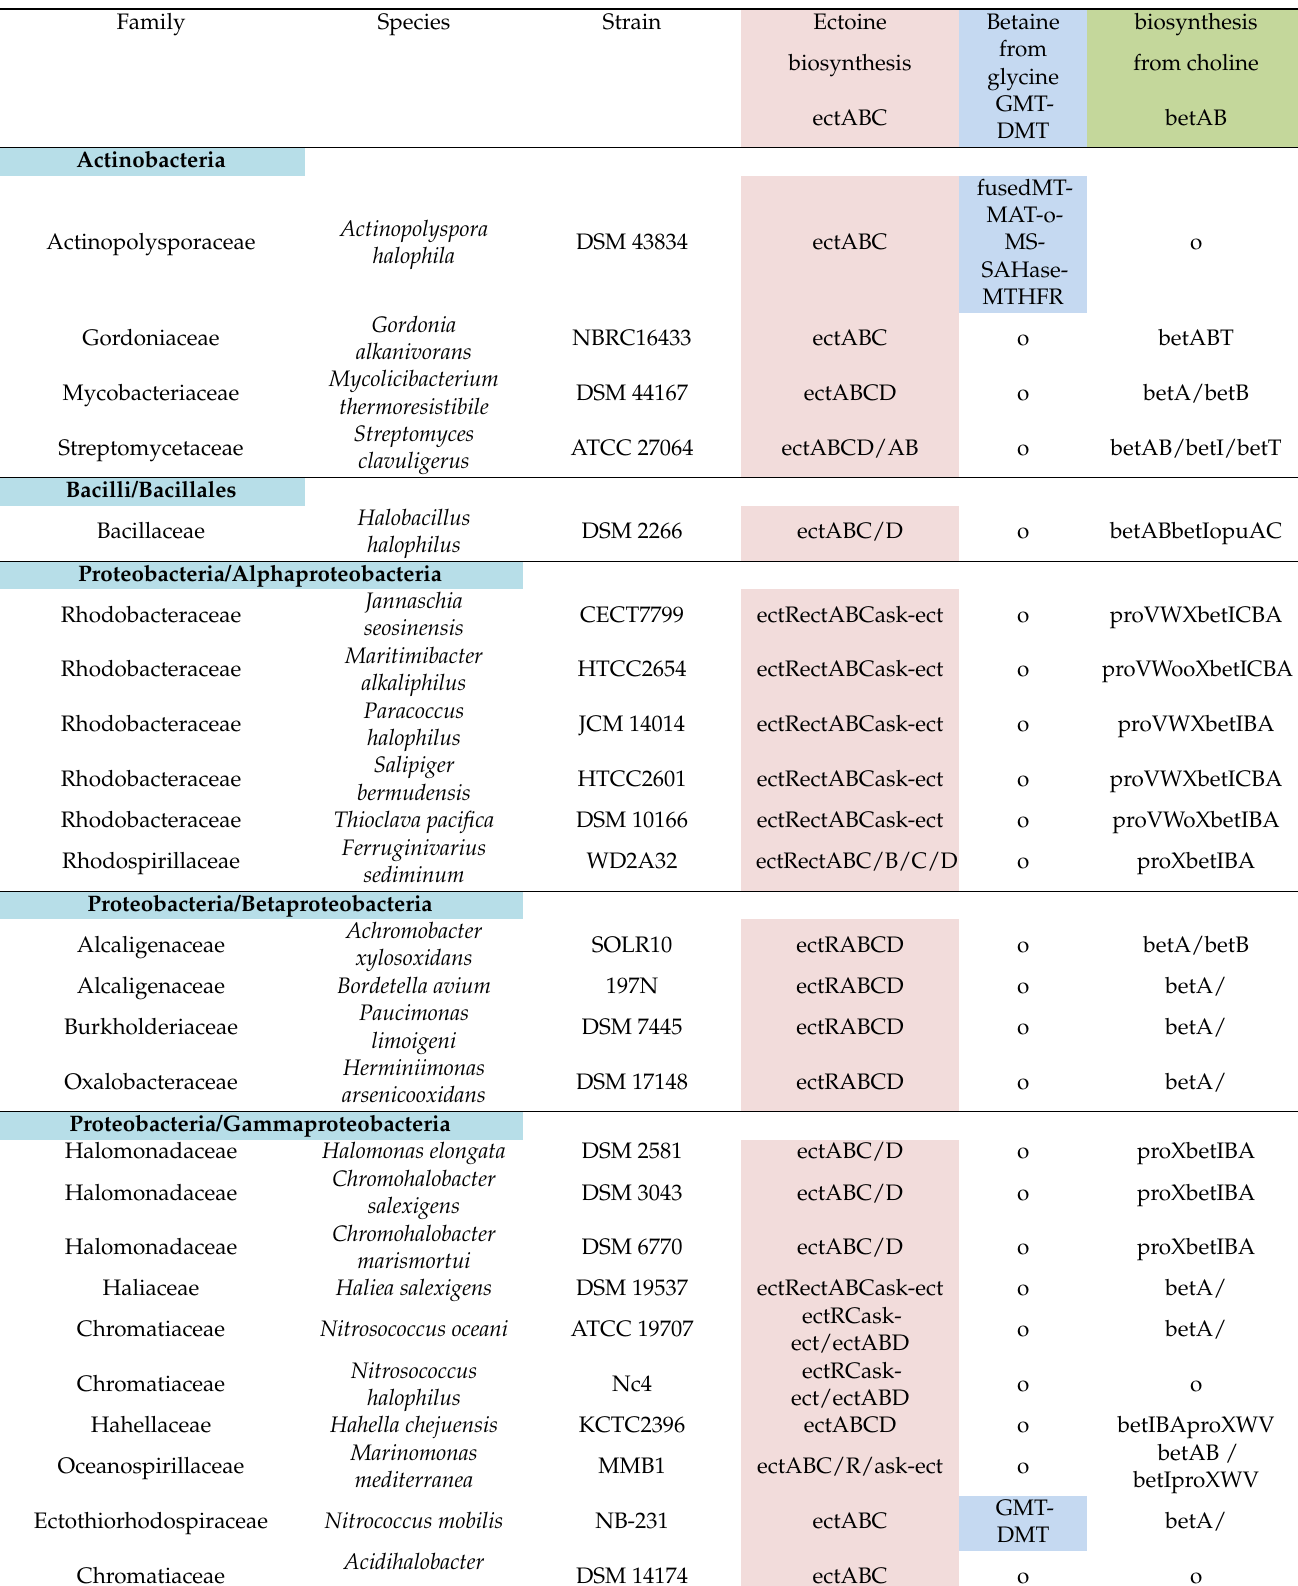
Table 4. Ectoine and betaine biosynthesis of selected chemotrophic bacteria a